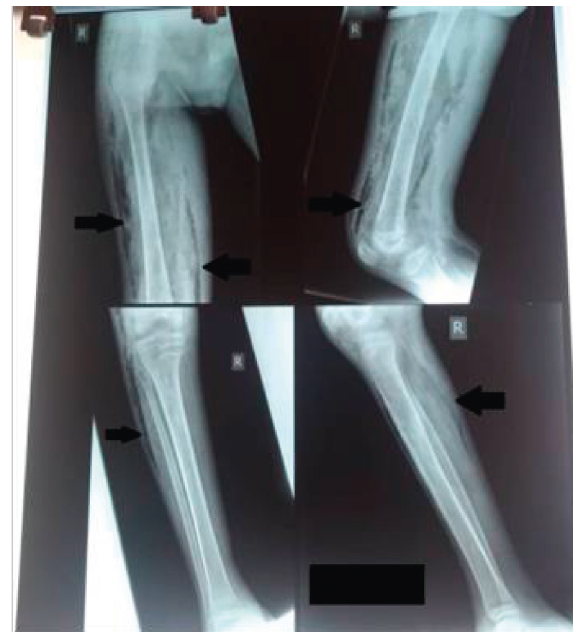
Figure 2: X-ray images showing gas pockets in the right thigh and leg.